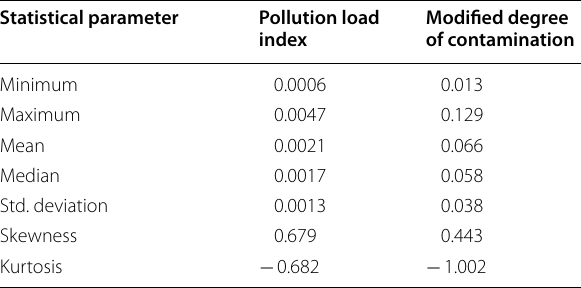
Table 12 Statistical parameters of pollution load index